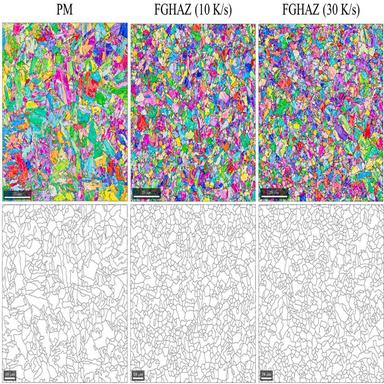
EBSD HAB orientation and HAB demarcation plots for X100Q PM, FGHAZ (10 K/s), and FGHAZ (30 K/s).